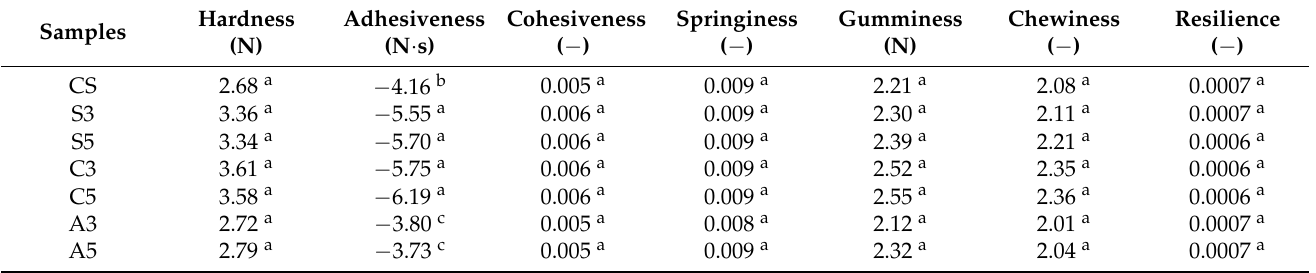
Table 5. Textural properties of 3D printed samples for different proteins at different